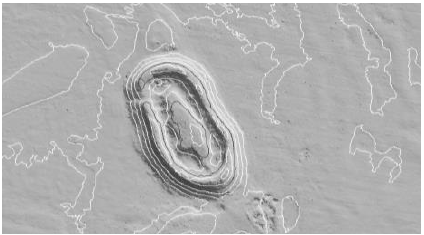
Figure 15. Object 1 - known settlement – profiles A-B and Figure 12. Object 2 - known settlement – digital terrain model with contour lines